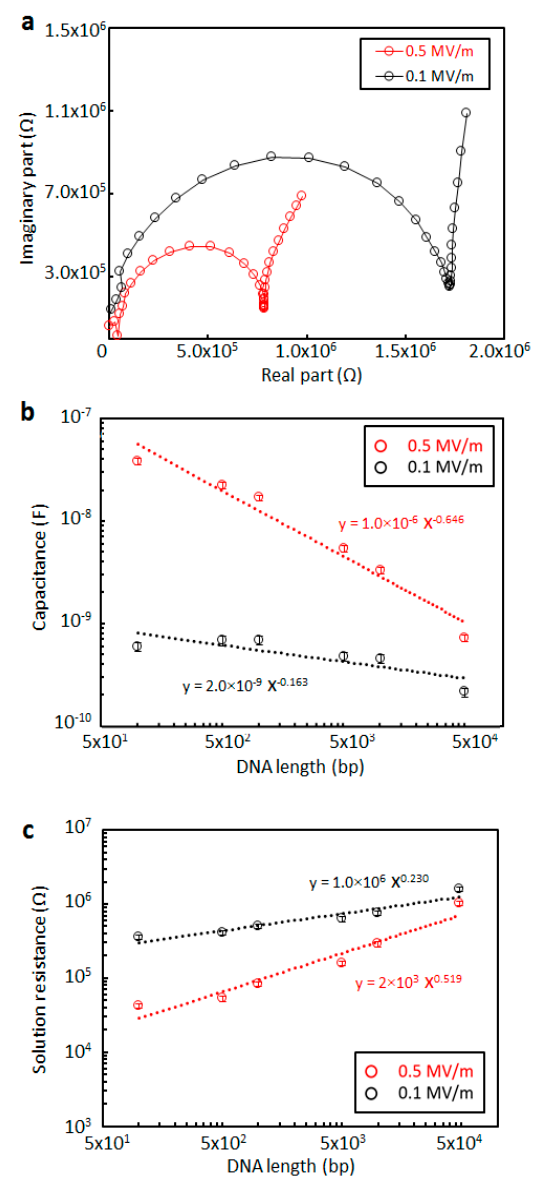
Figure 7. Electrical impedance values of DNA solutions as functions of length compared between 0.5 and 0.1 MV/m. ( a ) A typical Nyquist plot for 10 kbp DNA at a concentration of 119 ng/mL. ( b ) CPE DNA and ( c ) R s values obtained from the measured impedance of 100 bp, 500 bp, 1000 bp, 5000 bp, 10,000 bp, and 48.5 kbp DNA solutions at a concentration of 119 ng/mL using the equivalent circuit model.